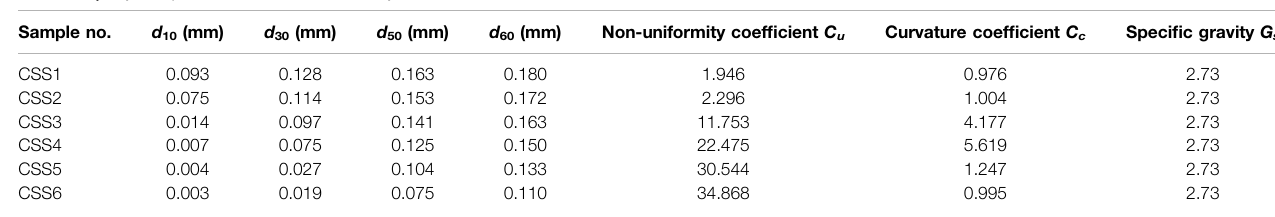
TABLE 1 | Physical parameters of calcareous silty sand. Sample